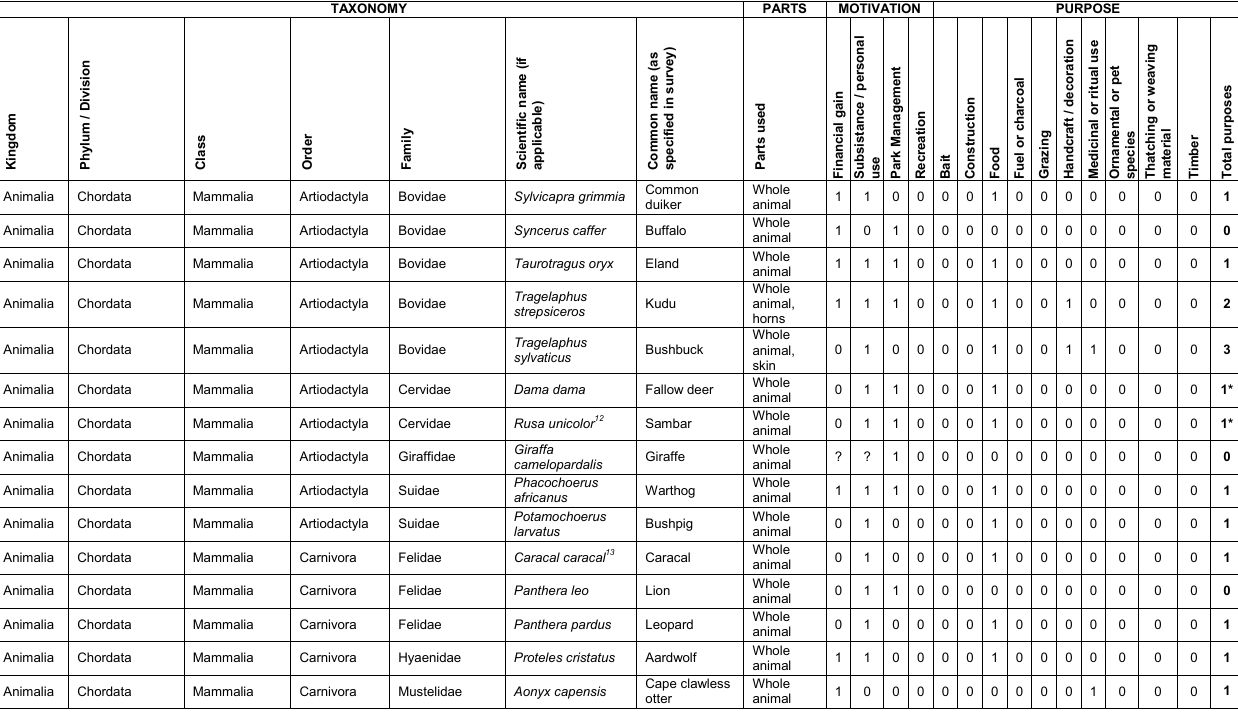
Animalia Chordata Mammalia Carnivora Felidae Panthera leo Lion Whole animal 0 1 1 0 0 0 0 0 0 0 0 0 Animalia Chordata Mammalia Carnivora Felidae Panthera pardus Leopard Whole animal 0 1 0 0 0 0 1 0 0 0 0 0 Animalia Chordata Mammalia Carnivora Hyaenidae Proteles cristatus Aardwolf Whole animal 1 1 0 0 0 0 1 0 0 0 0 0 Animalia Chordata Mammalia Carnivora Mustelidae Aonyx capensis Cape clawless otter Whole animal 1 0 0 0 0 0 0 0 0 0 1